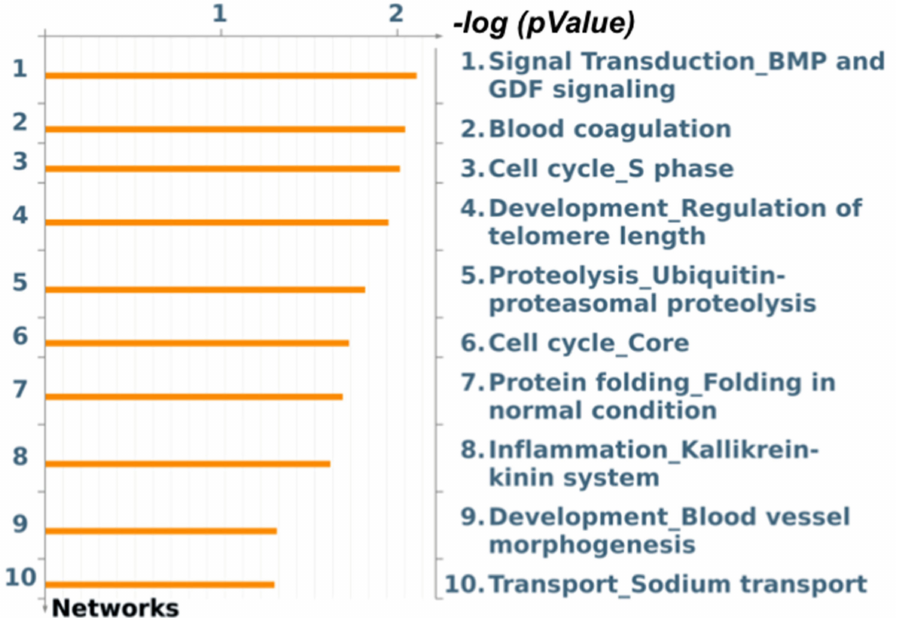
Figure 1. Top 10 enriched process networks identified by MetaCore software from the list of differen- tially expressed genes (FDR 10%) in the liver of pigs fed with two different levels of soybean oil in the diet (1.5% and 3.0% of soybean